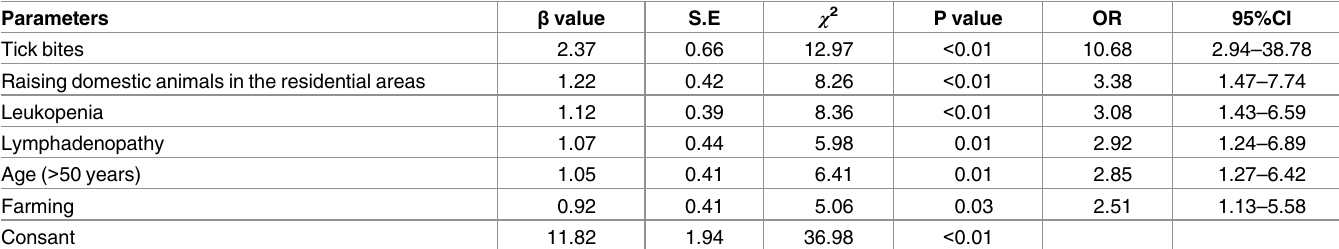
Table 3. Prediction model of SFTSV infection by combining demographic, clinical and epidemiological parameters (Model 3). Parameters